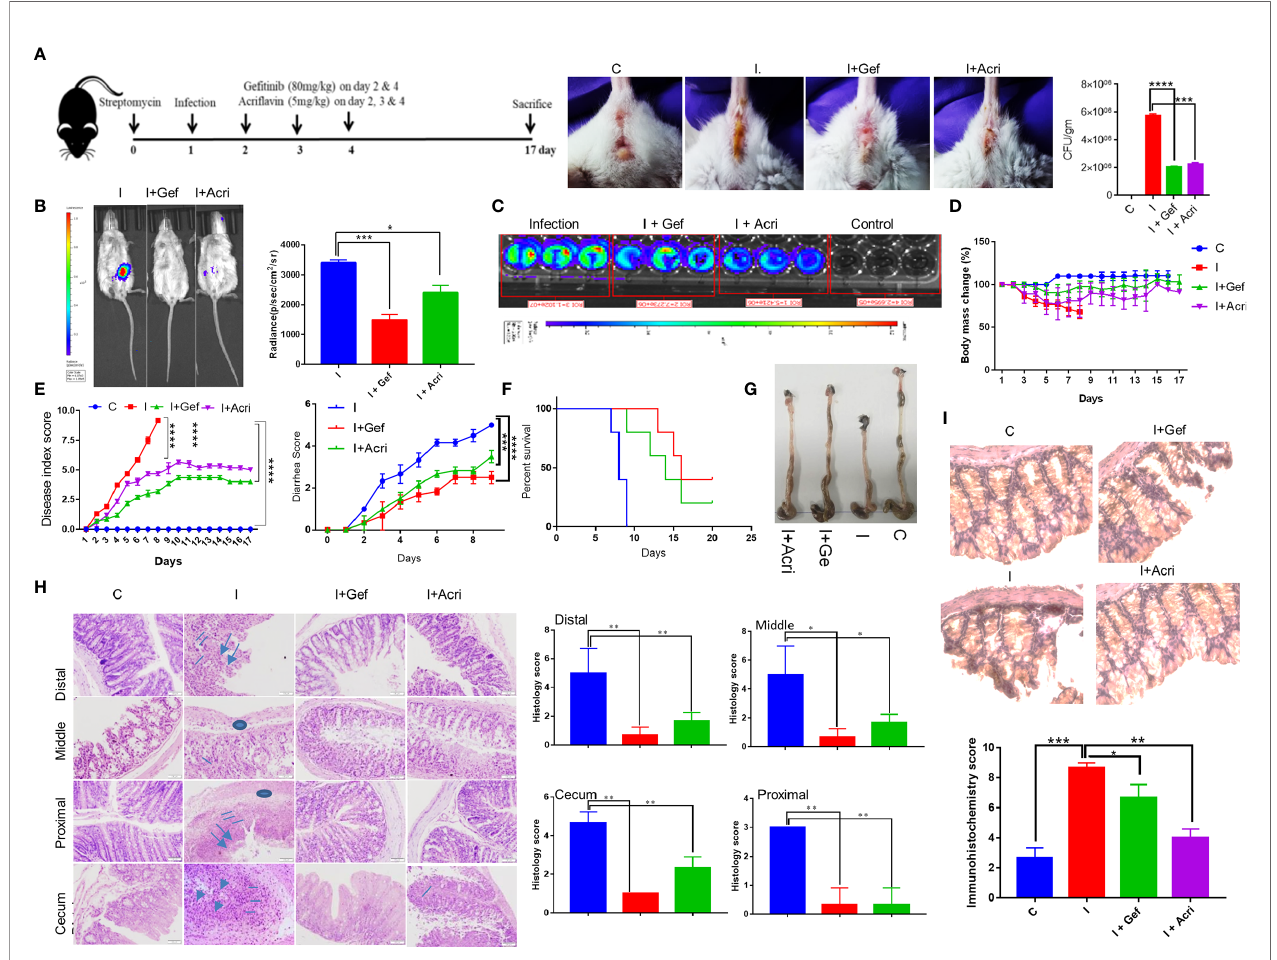
FIGURE 4 | Inhibition of EGFR signaling suppresses S. Typhimurium infection in mice. Recovery of chronically S. Typhimurium infected FVB mice was studied in the presence of Ge fi tinib or Acri fl avine. (A) Shows the pictorial representation of the dose regime for the establishment of infection and Ge fi tinib/Acri fl avin treatment. Panel a (right), shows mouse images indicating diarrhea index for 6 th post-infection. The stool was collected and plated on SS agar to determine S. Typhimurium colony formation (a, Far right). (B) In vivo imaging and intensity quantitation (right panel) of FVB mice infected with S. Typhimurium strain (Xen33) expressing luciferase on the 6 th day (n=5 mice per group). (C) Luminescence imaging of stool obtained from Xen33 infected mice, data indicates three independent experiments. Panel (D – F) shows the percentage change in body mass, disease index score, diarrhea score and percent survival (Kaplan Meier survival analysis) for FVB mice infected with S. Typhimurium in the presence or absence of Ge fi tinib or Acri fl avin (n=5 mice per group). (G) The image shows the length of the colon isolated from treated or untreated mice. (H) H & E staining (10X) of the proximal, middle and distal colon along with cecum showing regions of ulcers (arrow), in fl ammation (line), edema (circle)of different groups along with their histological scores. (I) Immunohistochemistry images (40X) showing expression of HIF-1 a and its quanti fi cation in the colon (n=5). Data representative of triplicates and repeated three times each individual experiments *P < 0.05, **P < 0.01, ***P < 0.001, ****P < 0.0001, ns-non-signi fi cant. (Student ’ s t-test and one-way